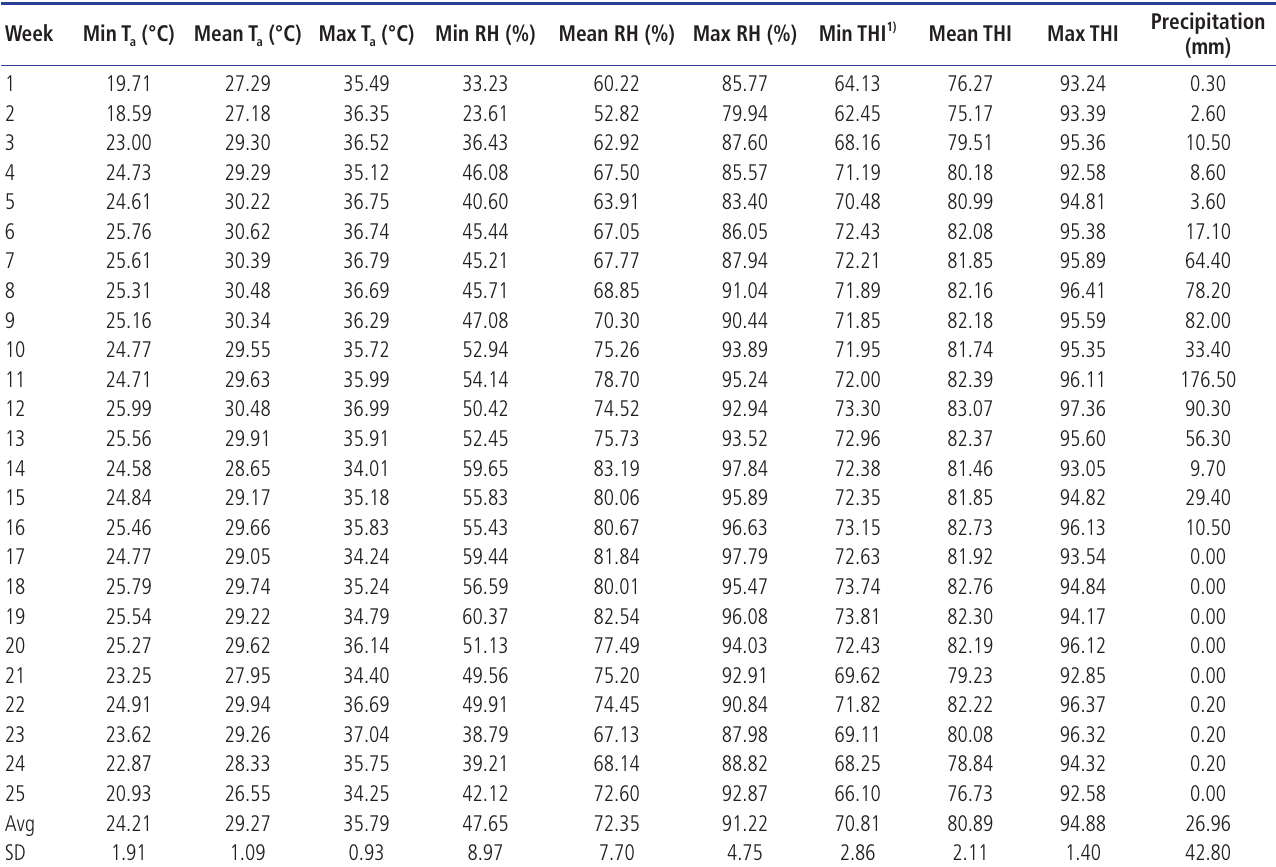
Table 2. Ambient temperature, mean relative humidity, and mean temperature-humidity index